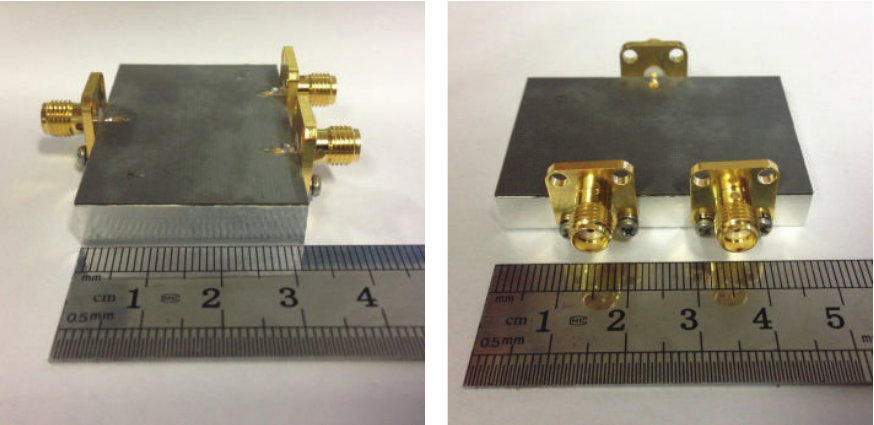
Figure 5: Photograph of the proposed novel filter integrated power divider.